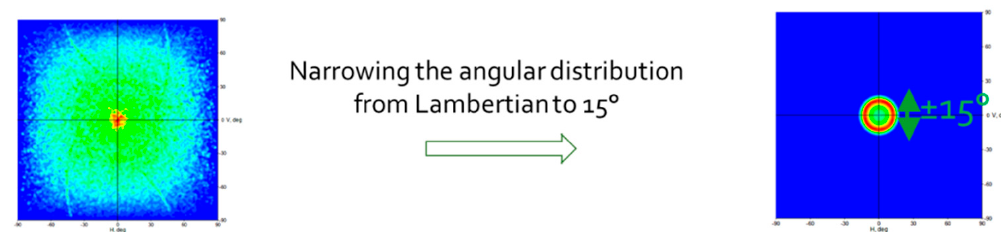
Figure 19. LENS Pixel angular distribution CPC narrowing, LightTools simulation .